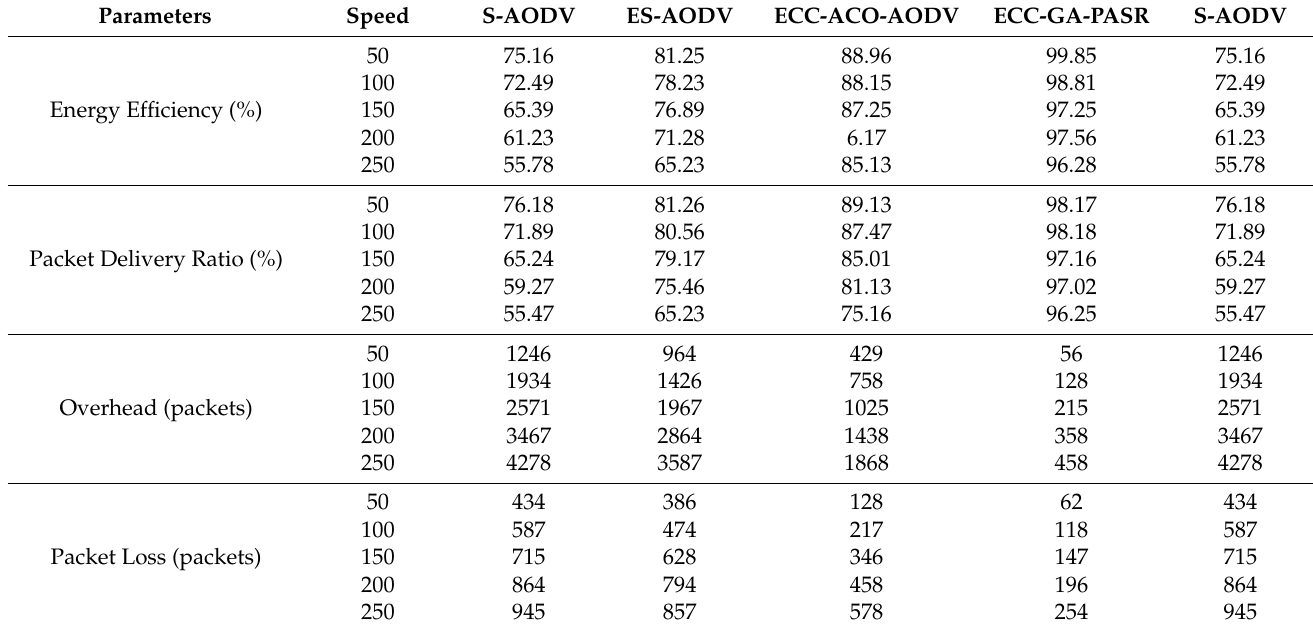
Table 8. Performance Analysis of Energy Efficiency, Packet Delivery Ratio, overhead, and Packet Loss concerning varying